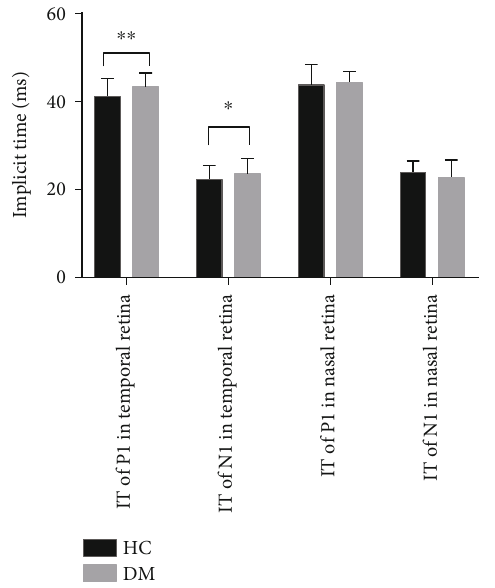
Figure 2: The implicit time of P1 and N1 waves in temporal and nasal retina between HC and DM patients.